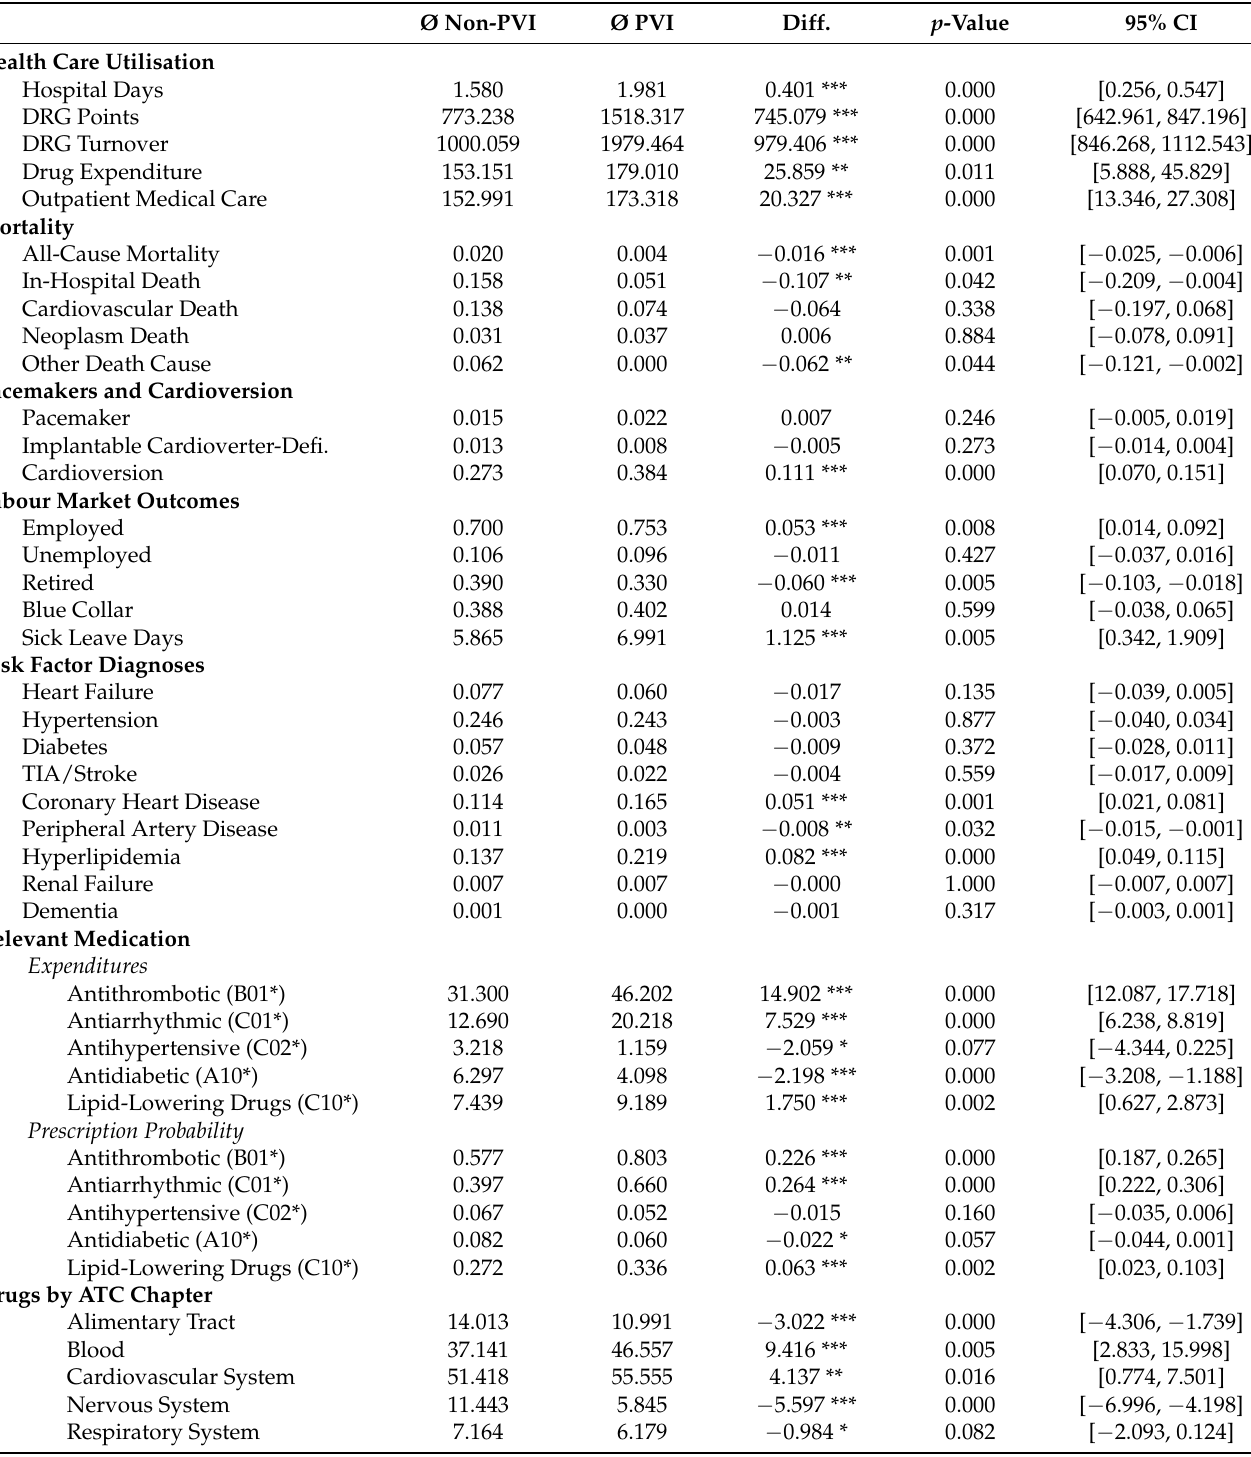
Table 2. Short-term Outcomes eight quarters after first hospitalization for atrial fibrillation. Ø